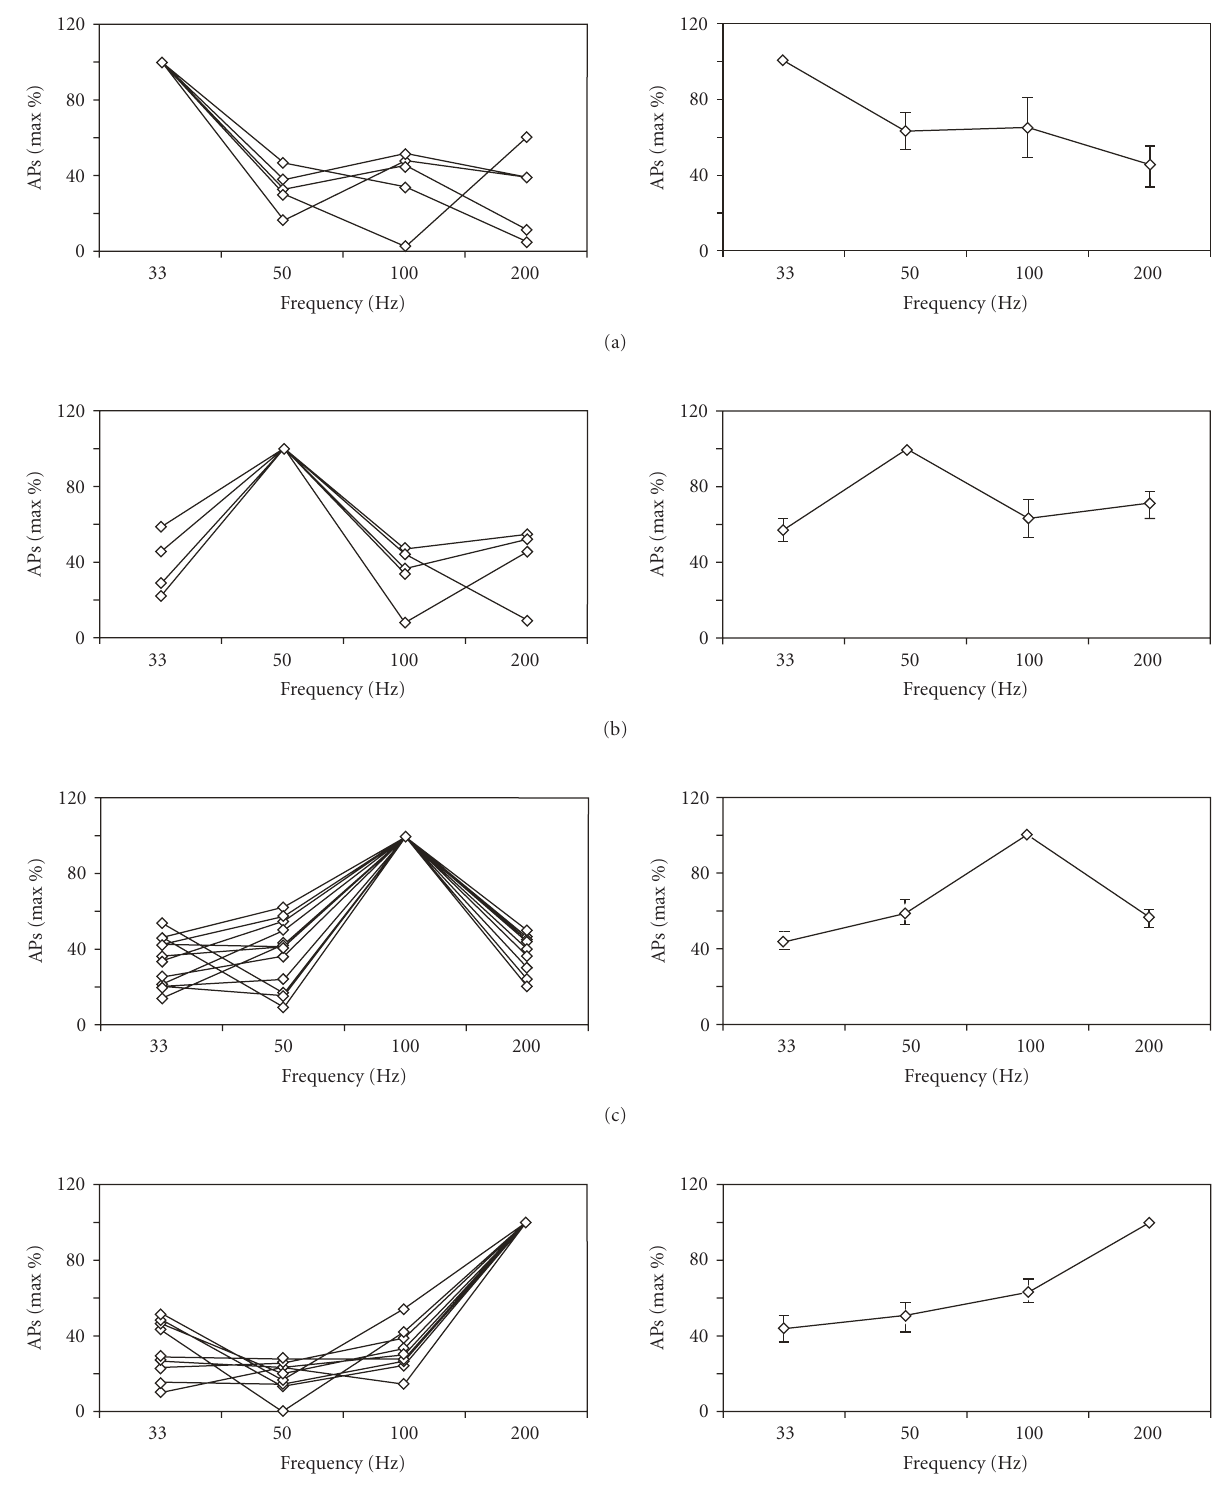
Figure 4: Frequency response functions of MON units. For this graph, spike activity of each unit was normalized to the greatest numbers of spikes elicited during the entire time of stimulation at any of the four frequencies presented. Left, response functions of individual units. Right, average ± one standard deviation of the functions shown on the left. Units exhibited low-pass (a), band-pass (b, c) or high-pass characteristics